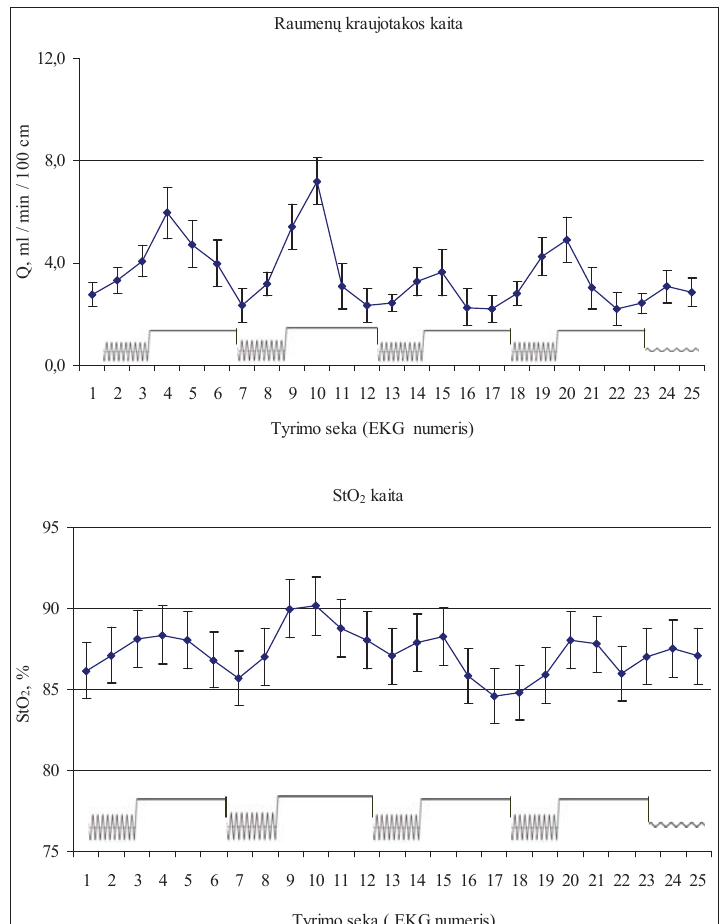
Pastaba . — kv ė pavimo pratimo